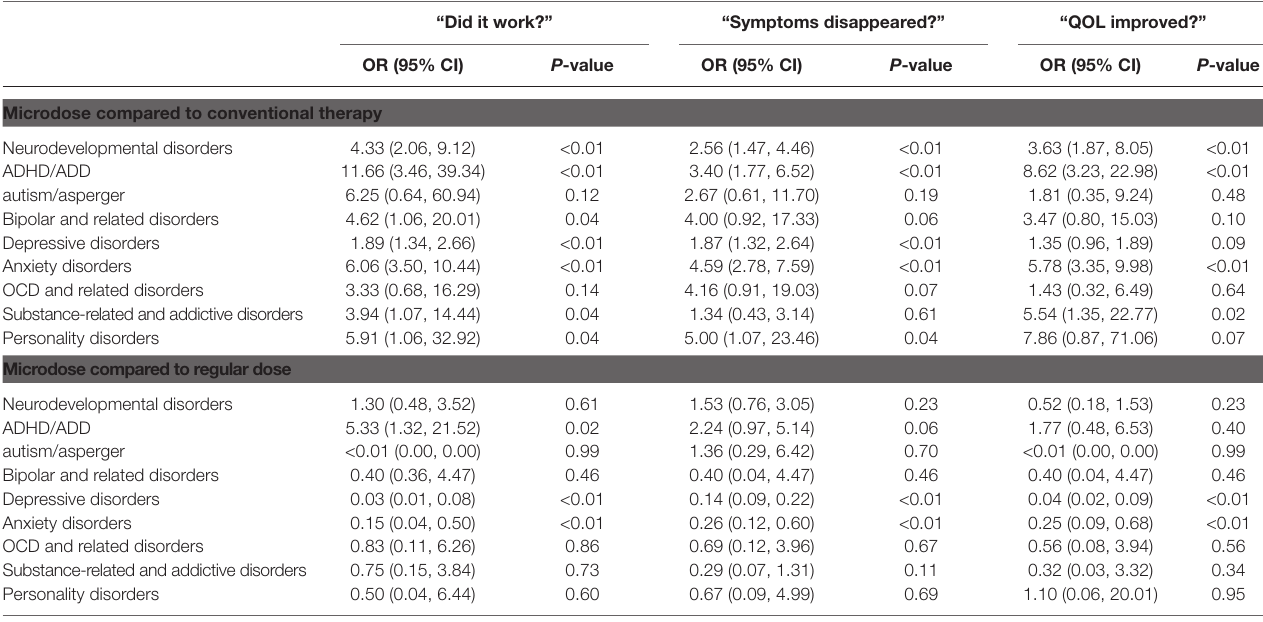
TABLE 2 | The odds ratio for SRE of MDP compared to conventional treatment and regular doses compared for each of the three effectiveness questions per sub- category of mental disorders a . “Did it work?” “Symptoms